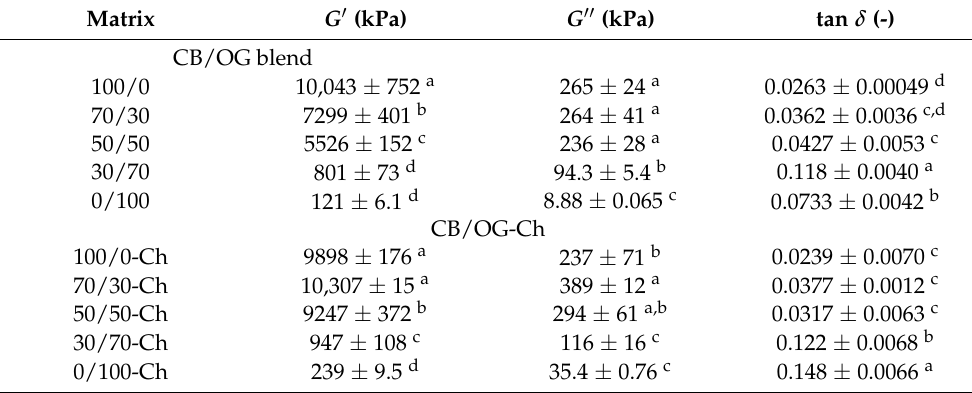
10,307 ± 15 a 9247 ± 372 b 294 ± 61 a,b 947 ± 108 c 239 ± 9.5 d 0.148 ± 0.0066